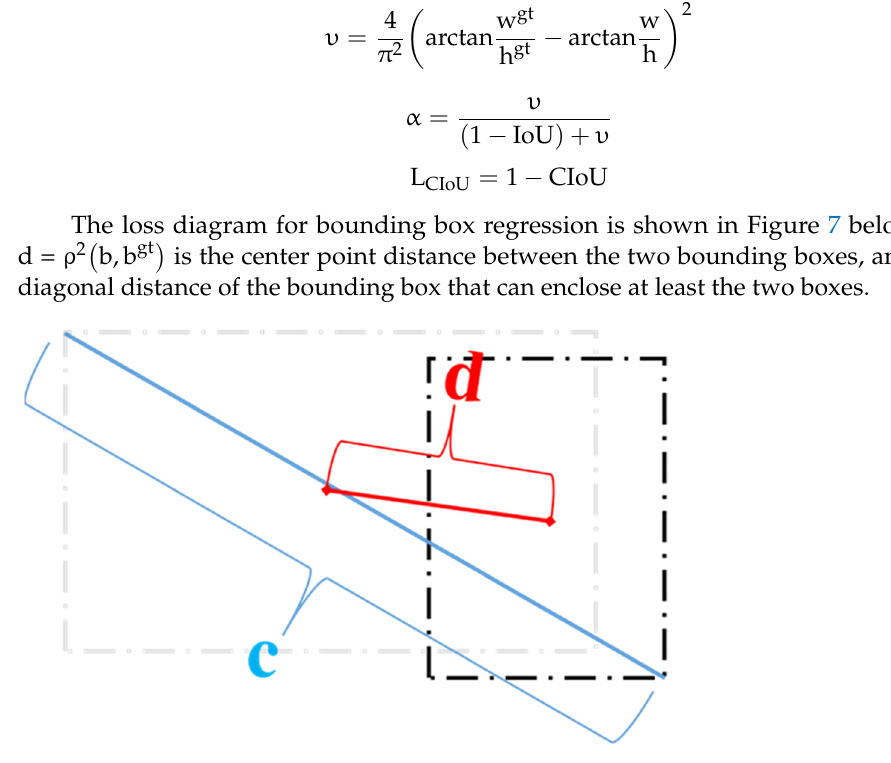
Figure 7. Illustration of CIoU loss